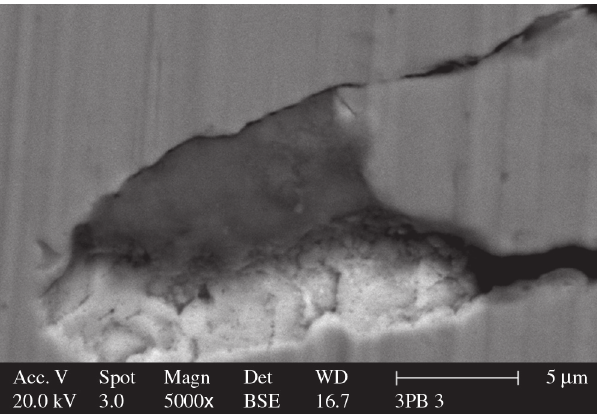
Figure 8. Storage of wear debris in the pit; SEM image, BSE mode.